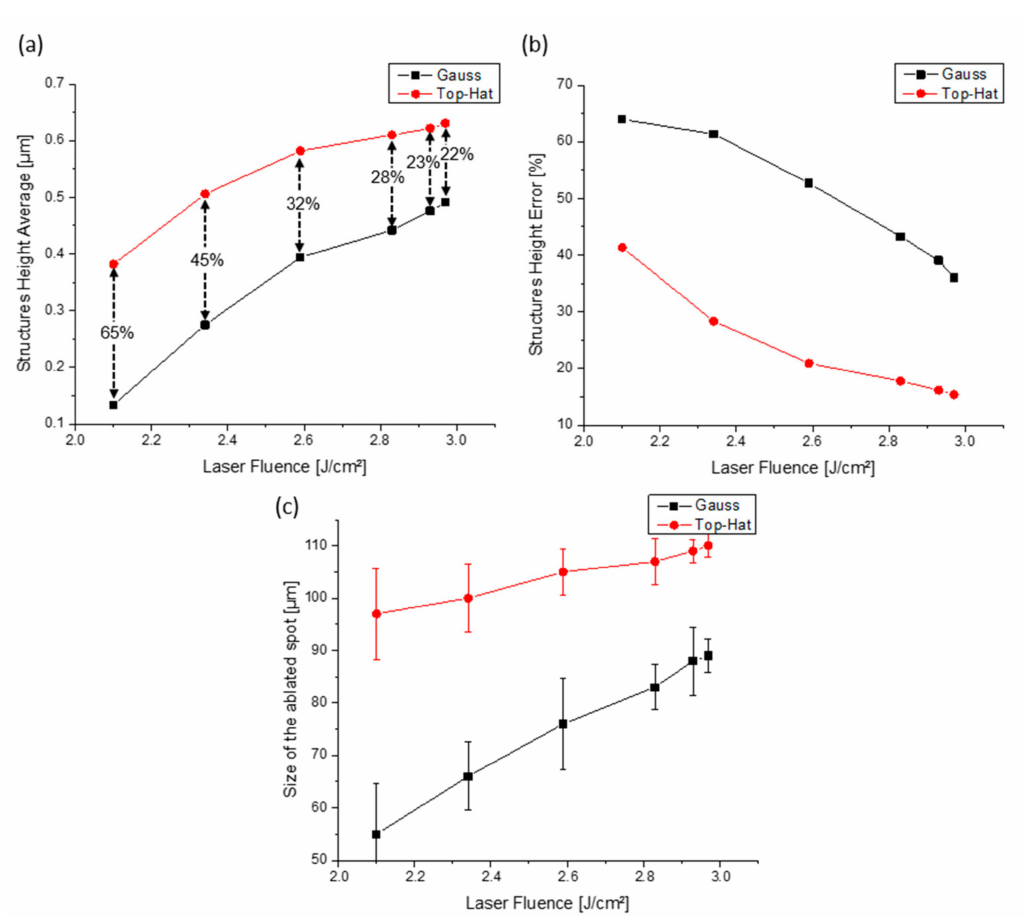
Figure 4. Topographical parameters of hole-like structured steel samples with both Gaussian and Top-hat beams: ( a ) average structure height, ( b ) structure height error, ( c ) size of the ablated spot at different laser fluence values. The lines serve only as a guide to the